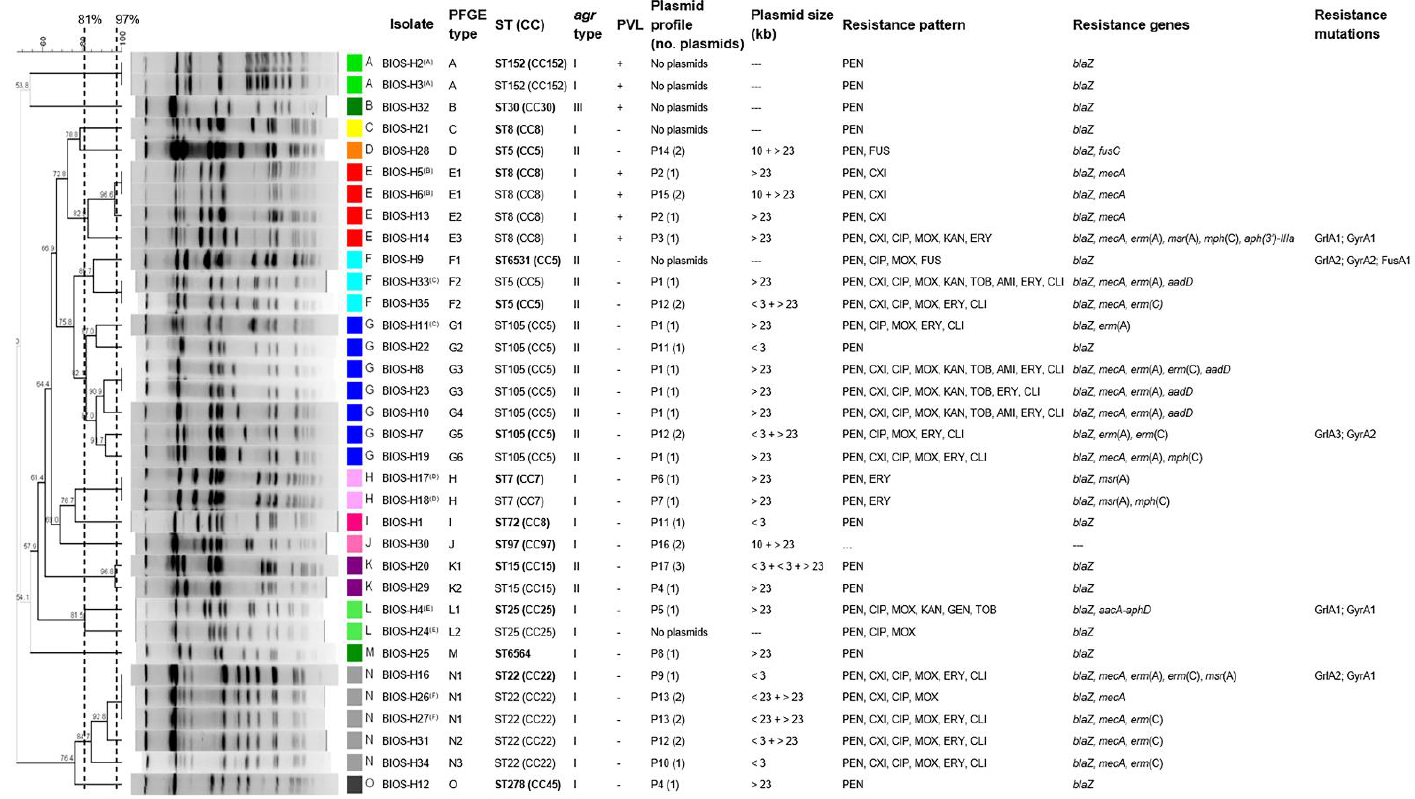
Figure 1. Sma I-PFGE macrorestriction profile analysis of the S. aureus isolates associated with SSTIs in ambulatory patients and corresponding clonal lineages as determined by MLST and their correlation with PVL carriage and agr types, plasmid profiles, and phenotypic and genotypic resistance traits. The pairs of isolates recovered from different anatomical sites of the same patient are marked by (A) to (F), where each letter corresponds to a different patient. The dendrogram was built using Bionumerics and the UPGMA algorithm, using Dice coefficient, and an optimization of 0.5% and tolerance of band of 1%. The dashed lines correspond to the similarity criteria for considering isolates belonging to the same PFGE type ( ≥ 81%) or subtype ( ≥ 97%). Isolates sharing the same PFGE type or subtype were considered as belonging to the same sequence type (ST). The isolates subjected to MLST are indicated in bold-type. Each plasmid profile corresponds to a unique pattern of undigested and/or Eco RI-digested plasmids. CC: clonal complex; ST: sequence type; PFGE: pulsed-field gel electrophoresis; PVL: Panton–Valentine leucocidin; PEN: penicillin; CXI: cefoxitin; ERY: erythromycin; CLI: clindamycin; CIP: ciprofloxacin; MOX: moxifloxacin; KAN: kanamycin; GEN: gentamycin; TOB: tobramycin; AMI: amikacin; and FUS: fusidic acid. Resistance mutations: GrlA1: S80Y; GrlA2: S80F; GrlA3: S80Y, E84G; GyrA1: S84L; GyrA2: E88K; FusA1: A71V, H547Q,